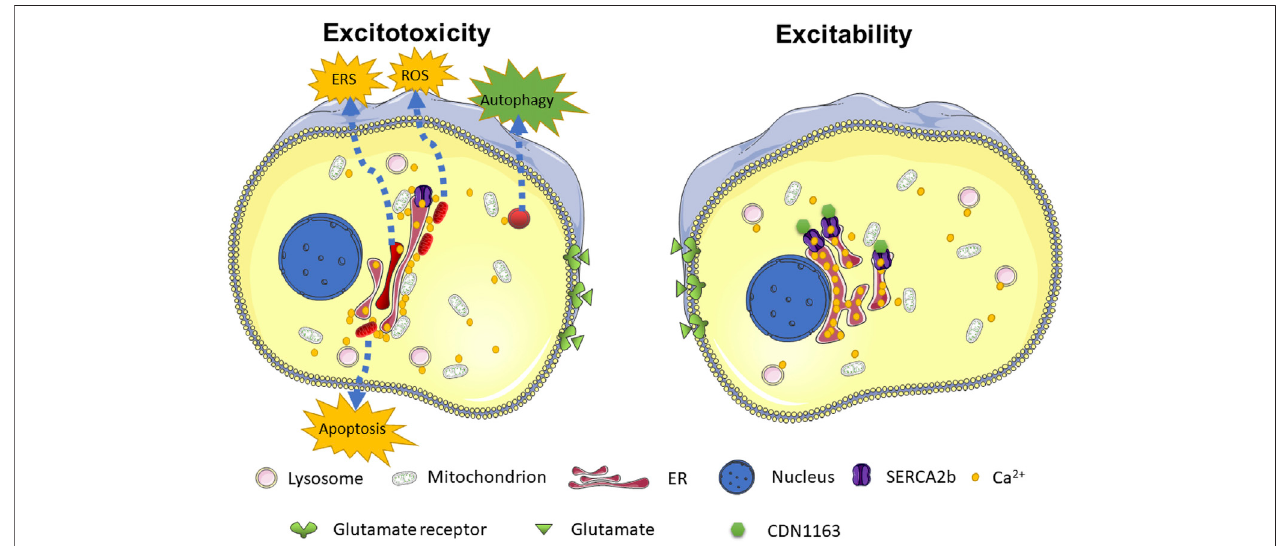
FIGURE 7 | Schematic model depicting the ER Ca 2+ depletion in response to glutamate-induced excitotoxicity. SERCA2b mutants increase susceptibility to glutamate-inducedexcitotoxicitybyexacerbatingERCa 2+ depletion.ERCa 2+ depletionleadstoincreasedlevelsofthe[Ca 2+ ] cyto andER-mitochondriacontact,whichin turn leads to abnormal activation of many Ca 2+ -dependent pathways, such as ERS, oxidative stress, apoptosis, autophagy, and ultimately promotes cell death. CDN1163 enhances SERCA2b activity and inhibits ER Ca 2+ depletion, maintaining intracellular Ca 2+ homeostasis. The affected dysfunctional mitochondria, lysosomes, and ER are highlighted in